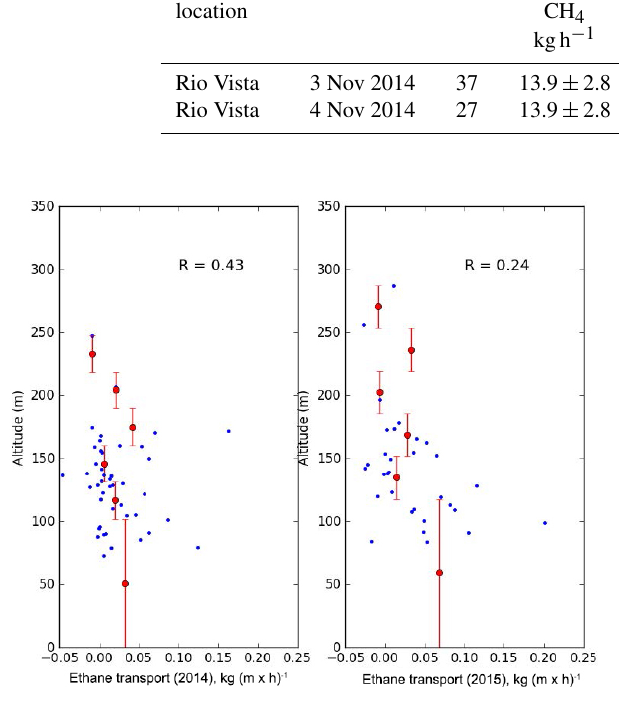
Figure 8. Ethane horizontal transport profiles for the Aerodyne con- trolled releases near Denver, Colorado, on 19 November 2014 ( (a) ) and in Bee Branch, Arkansas, on 3 October 2015 ( (b) ). Blue dots represent individual flight loop measurements and the red circles represent the bin average values for altitude intervals represented by the red